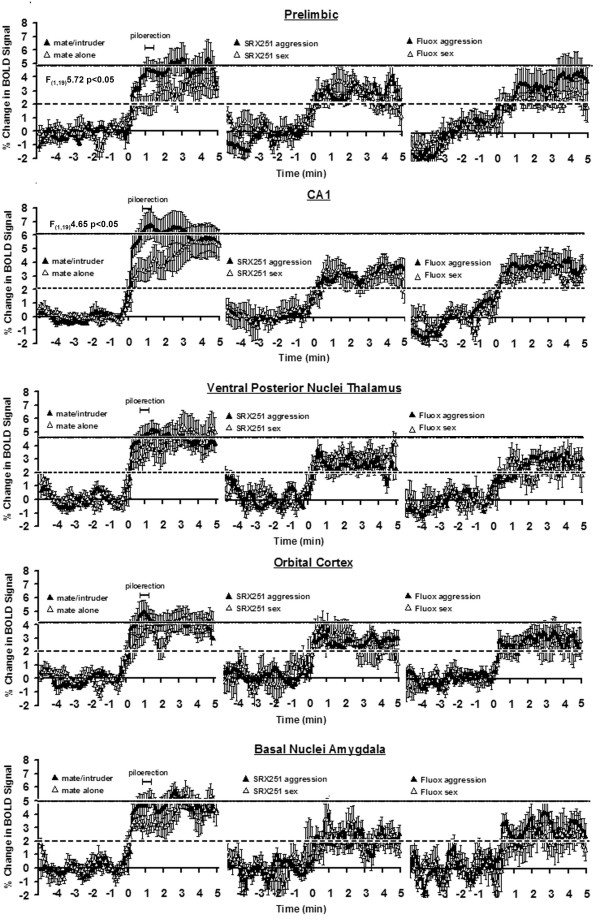
Change in BOLD signal in key areas of interest. See legend from figure 6.